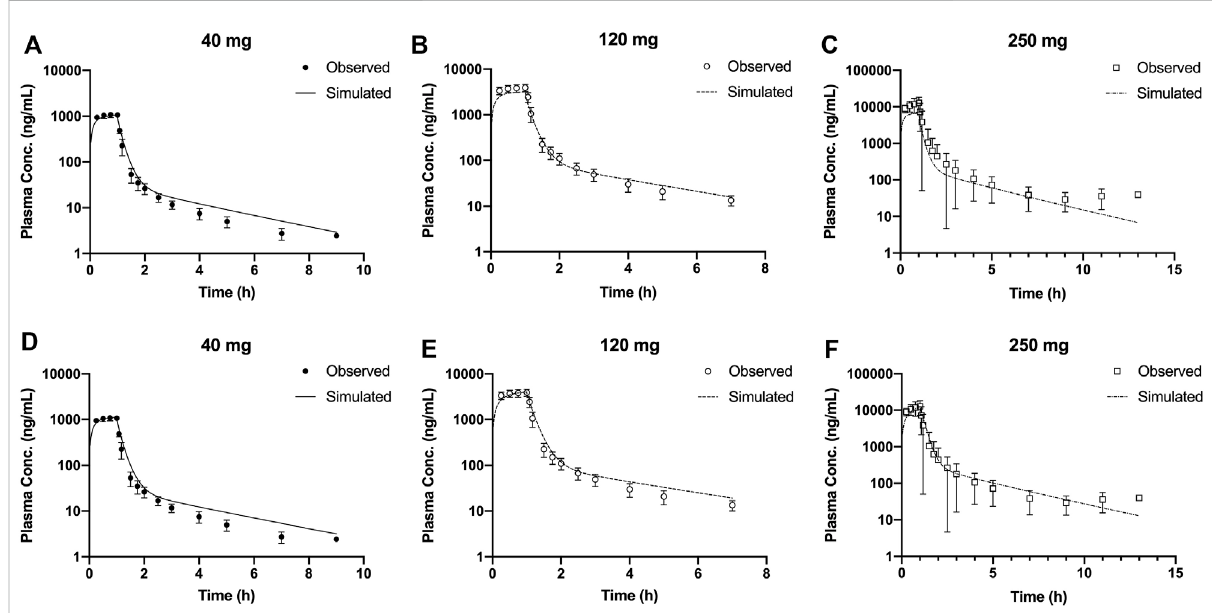
FIGURE 3 Mean observed (symbol ±SD) and simulated (lines) plasma concentrations for 40, 120, and 250 mg single doses with the original PBPK model (A – C) and the updated PBPK model (D – F) . PBPK, physiologically based pharmacokinetic.